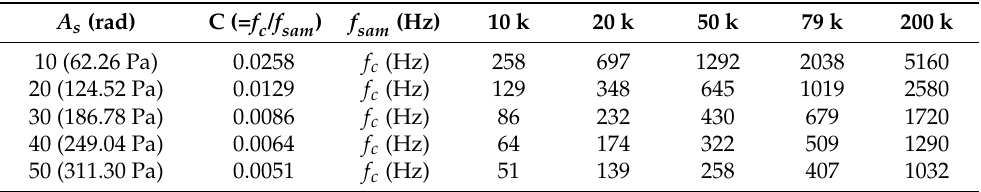
Table 3. Upper limits of the frequency response range of demodulated signals at different sound pressure and sampling